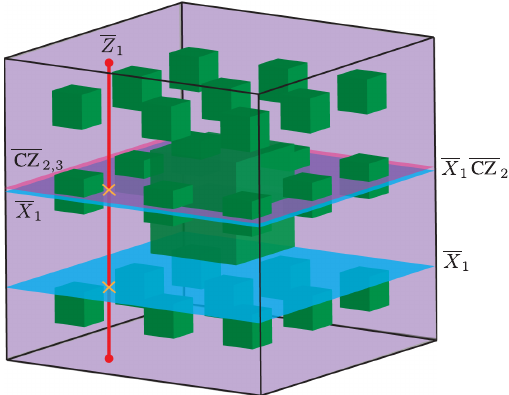
FIG. 31. Logical operators in the new stack code with exotic ) (green). The logical Z - hole boundaries ( m 1 s ( 2 ) , m 2 s ( 2 ) , m 3 s ( 2 ) 2,3 3,1 1,2 strings remain the same as those in the original stack code. A logical X -brane can only terminate on the outer boundaries. The combined logical brane X 1 CZ 2,3 can instead terminate on the exotic hole boundaries and its minimal support forms a Sierpi´nski carpet as